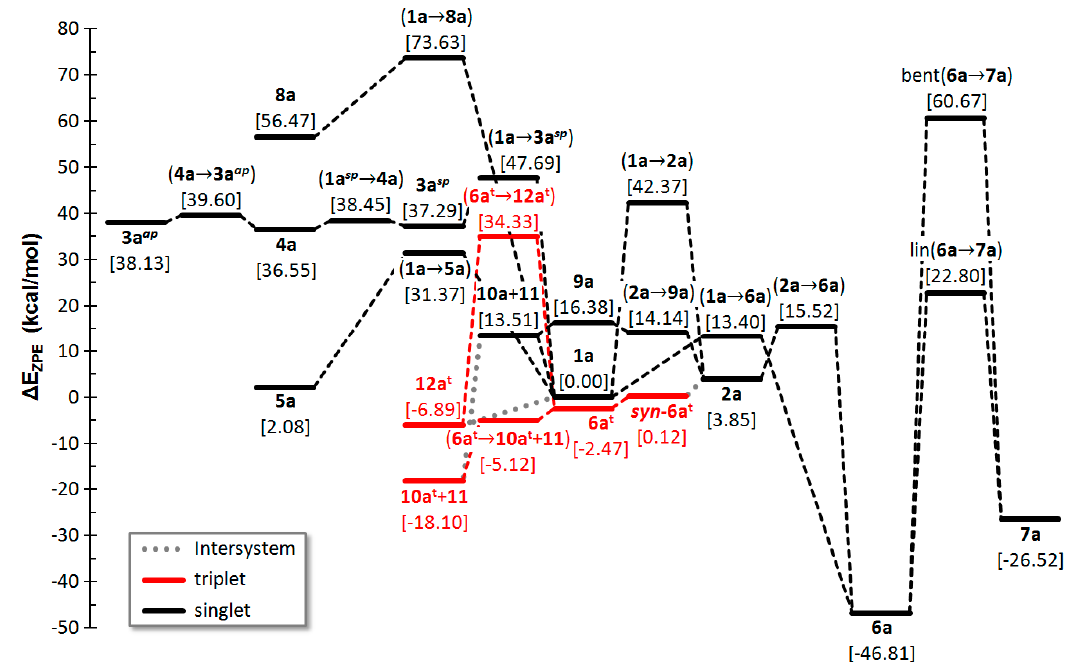
Figure 4. Computed (CCSD(T)/def2-TZVPP//B3LYP-D3/def2-TZVP) zero-point corrected energy profile for the interconversion of CHOP isomers.